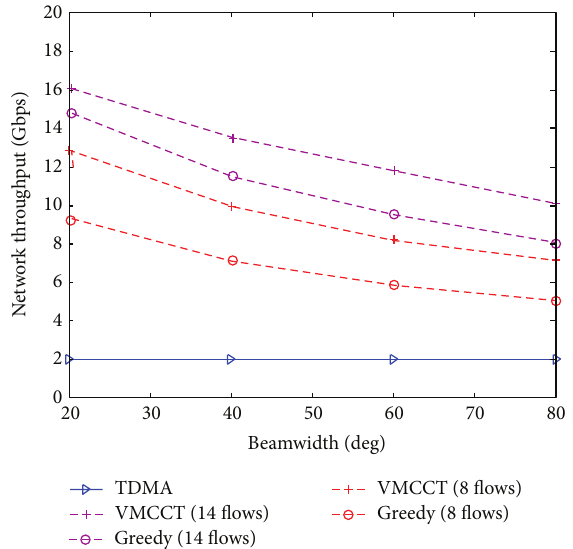
Figure 11: Network throughput versus increasing